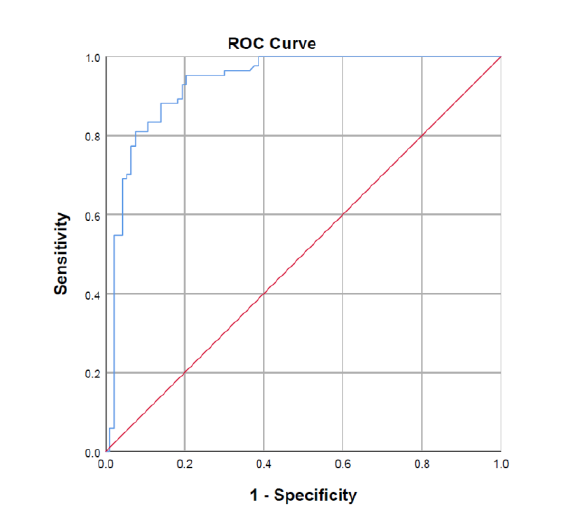
Figure 5 . AUC of Random Forest (93.4%)